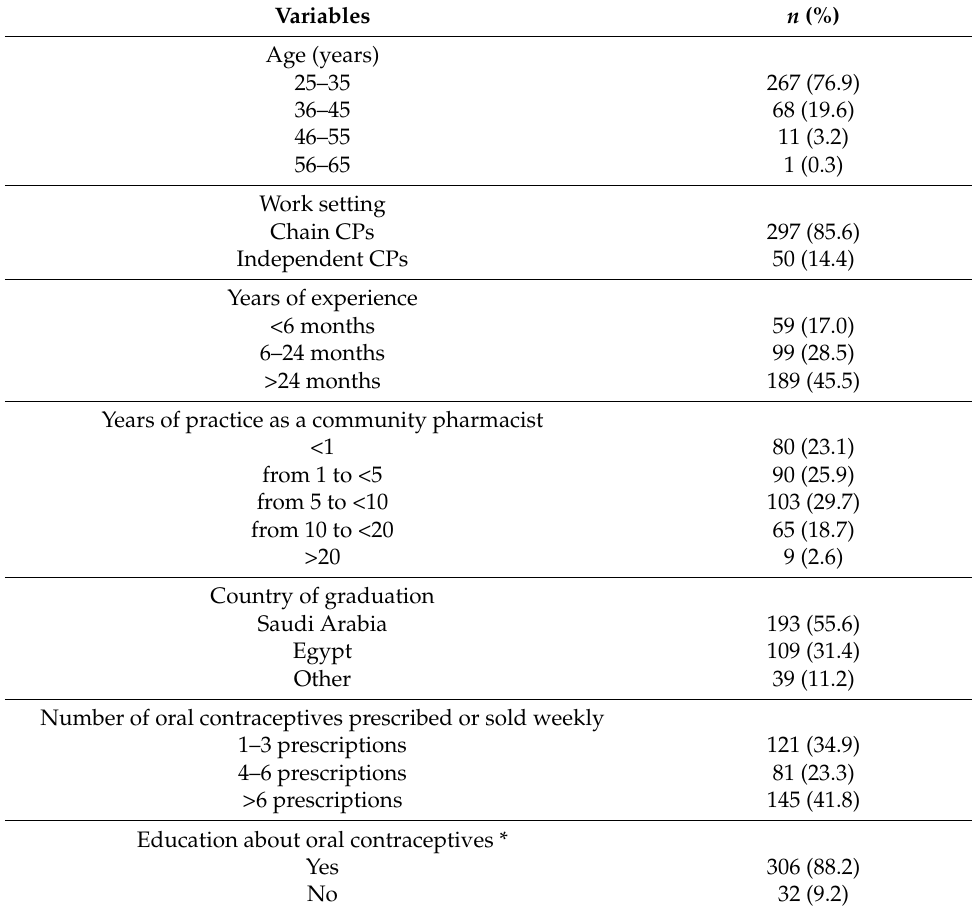
Table 1. Demographic data of the community pharmacists ( n = 347).